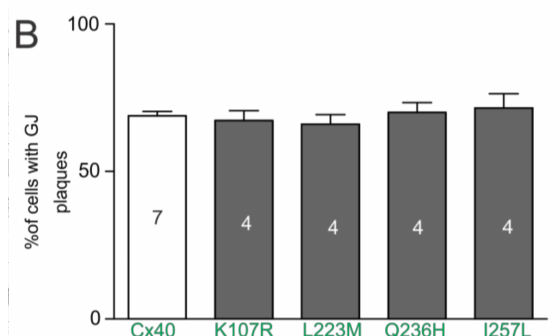
Figure 1. Localization of atrial fibrillation (AF)-linked Cx40 mutants. ( A ) Fluorescent images of HeLa cell clusters or pairs expressing YFP-tagged Cx40, K107R, L223M, Q236H, or I257L superimposed on their respective differential interference contrast (DIC) images. Cells expressing each of the AF-linked Cx40 mutants were able to form GJ plaque-like structures at the cell–cell interface similar to that of wildtype Cx40 (white arrows). Scale bars = 10 µ m; ( B ) the bar graph summarizes the percentage of cell pairs showing GJ plaque-like structures at the cell–cell interface for each mutant. No statistical difference was observed between any of the mutants and wildtype Cx40. Approximately 100 positively-transfected cell pairs were examined for each transfection. The total number of transfections is indicated on each bar.